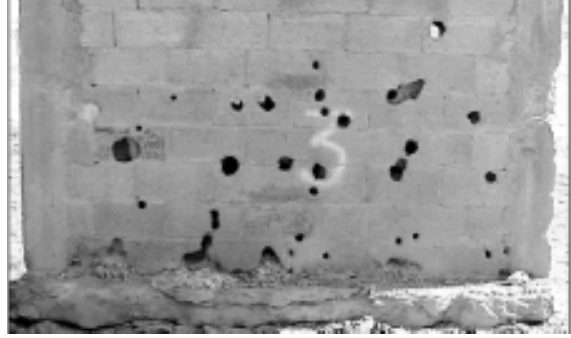
Fig. 10. Fragment-induced damage to hollow CMU wall from mortar round